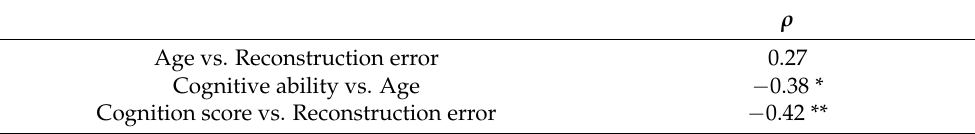
Table 1. Partial correlation of cognitive-score, reconstruction error and age. * p -value < 0.01; ** p -value <